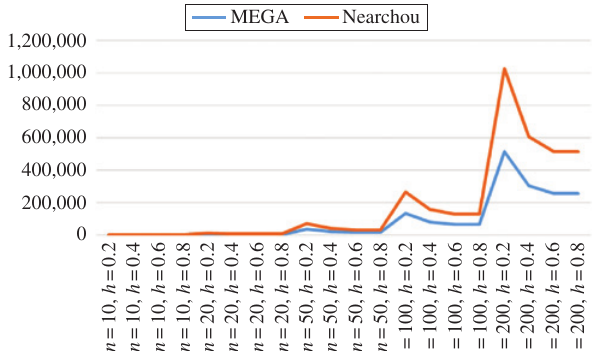
Figure 2: Graphical Representation of Results.